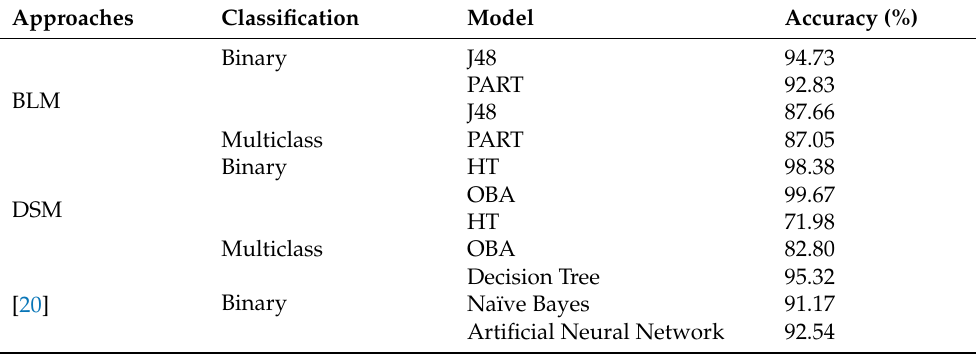
Table 6. Baseline comparison with existing work.